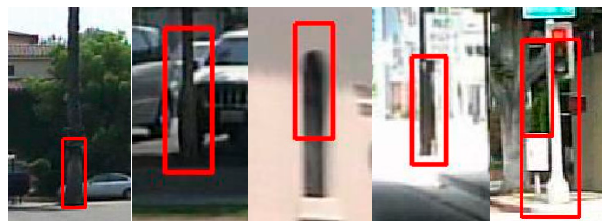
Figure 4. Common baseline activation functions. Best viewed in color.